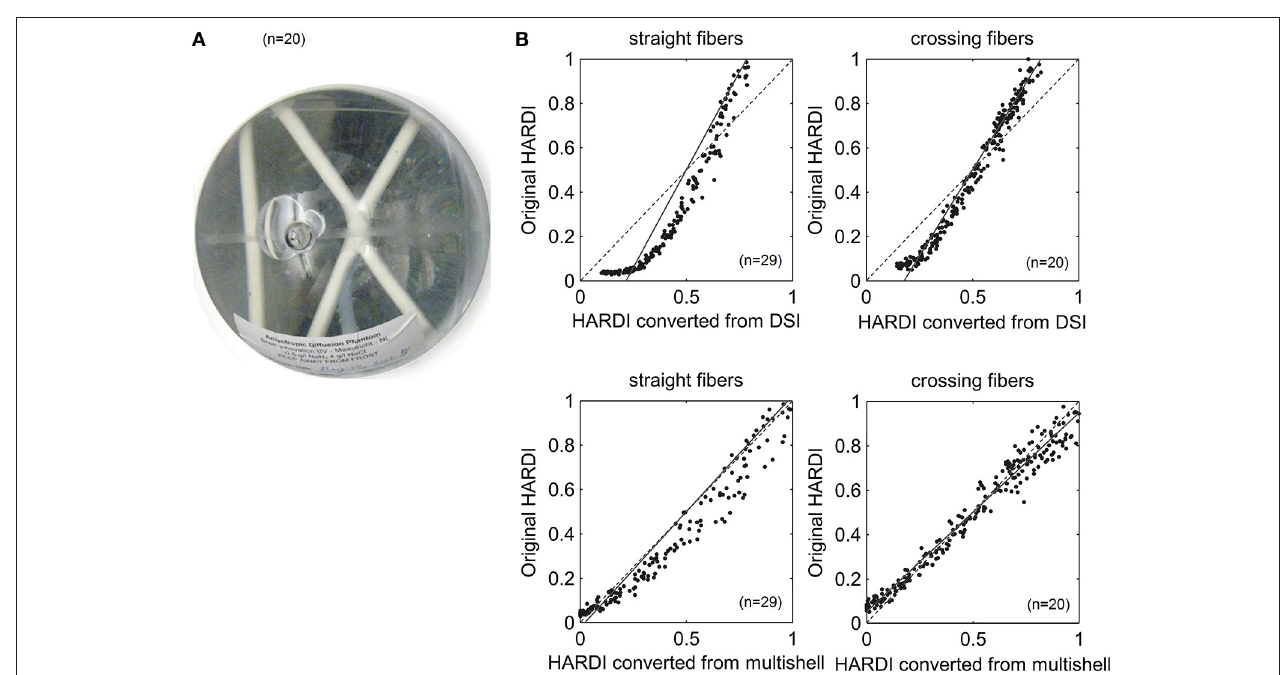
FIGURE 2 | (A) The layout of the anisotropic diffusion phantom consists of one straight fiber bundle and a pair of crossing bundles. (B) Scatter plots showing a signal correlation between the converted HARDI and the original HARDI in our phantom study. The dotted lines indicate identity. The converted HARDI was calculated from the multi-shell or DSI data, whereas the original HARDI was acquired from the MR scanner. All comparisons had a high correlation coefficient ( r > 0.9), suggesting that the converted HARDI data strongly predict the original HARDI images.